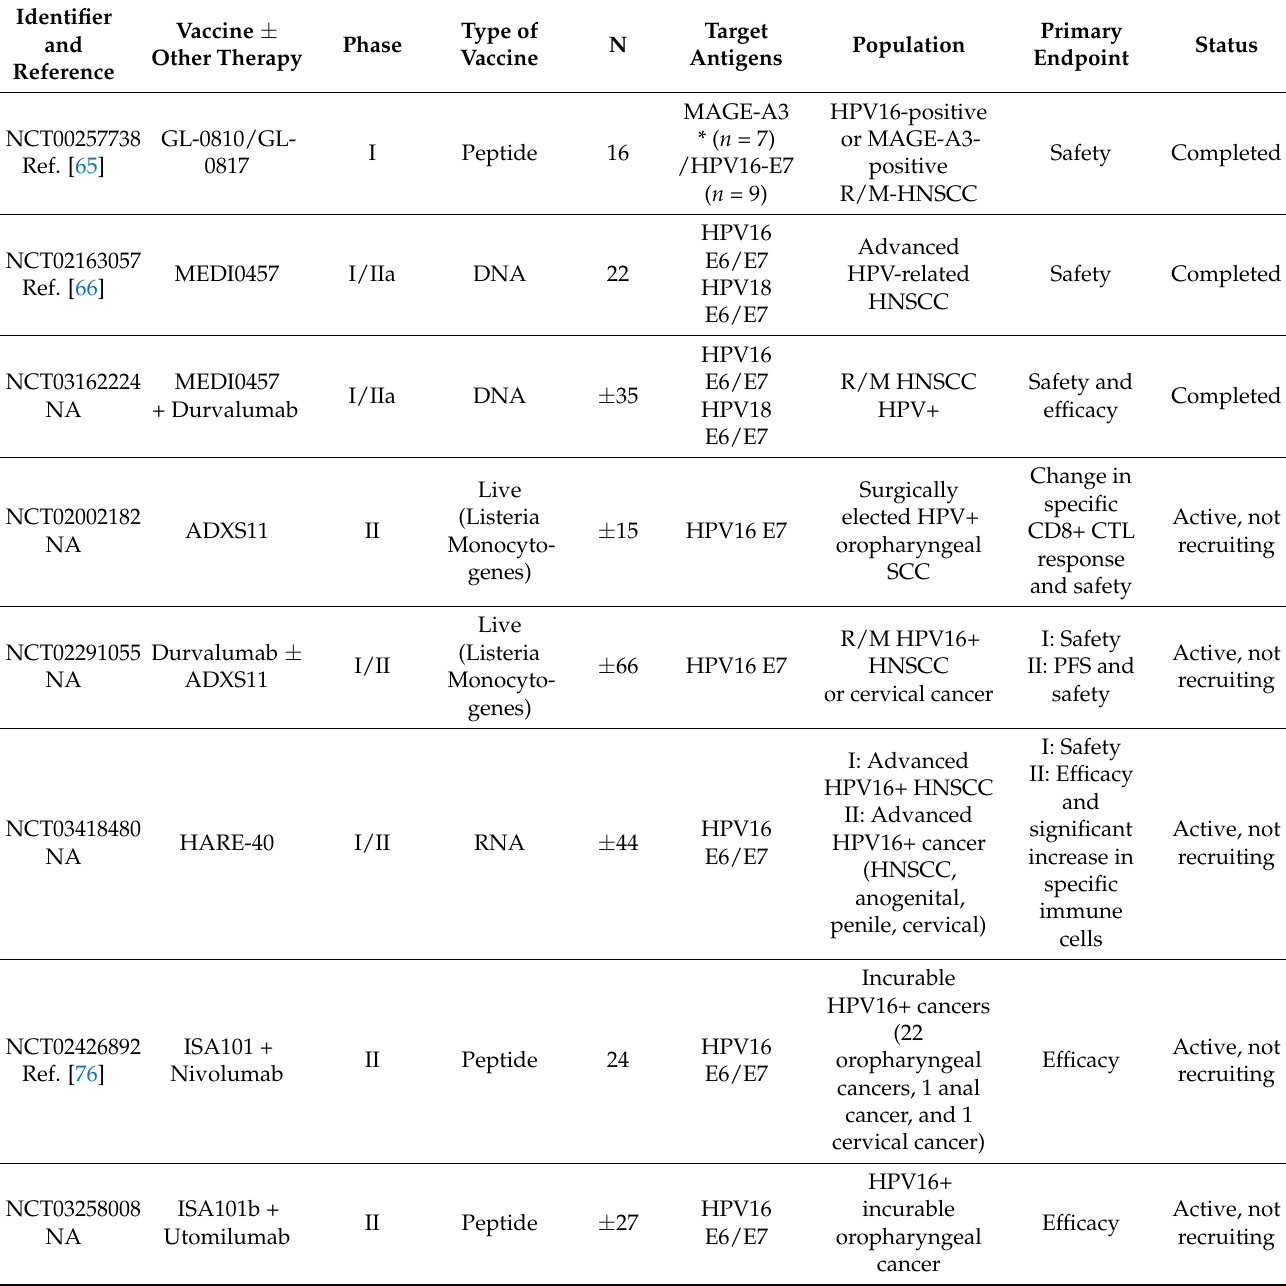
Table 1. Clinical trials in vaccines targeting HPV-associated